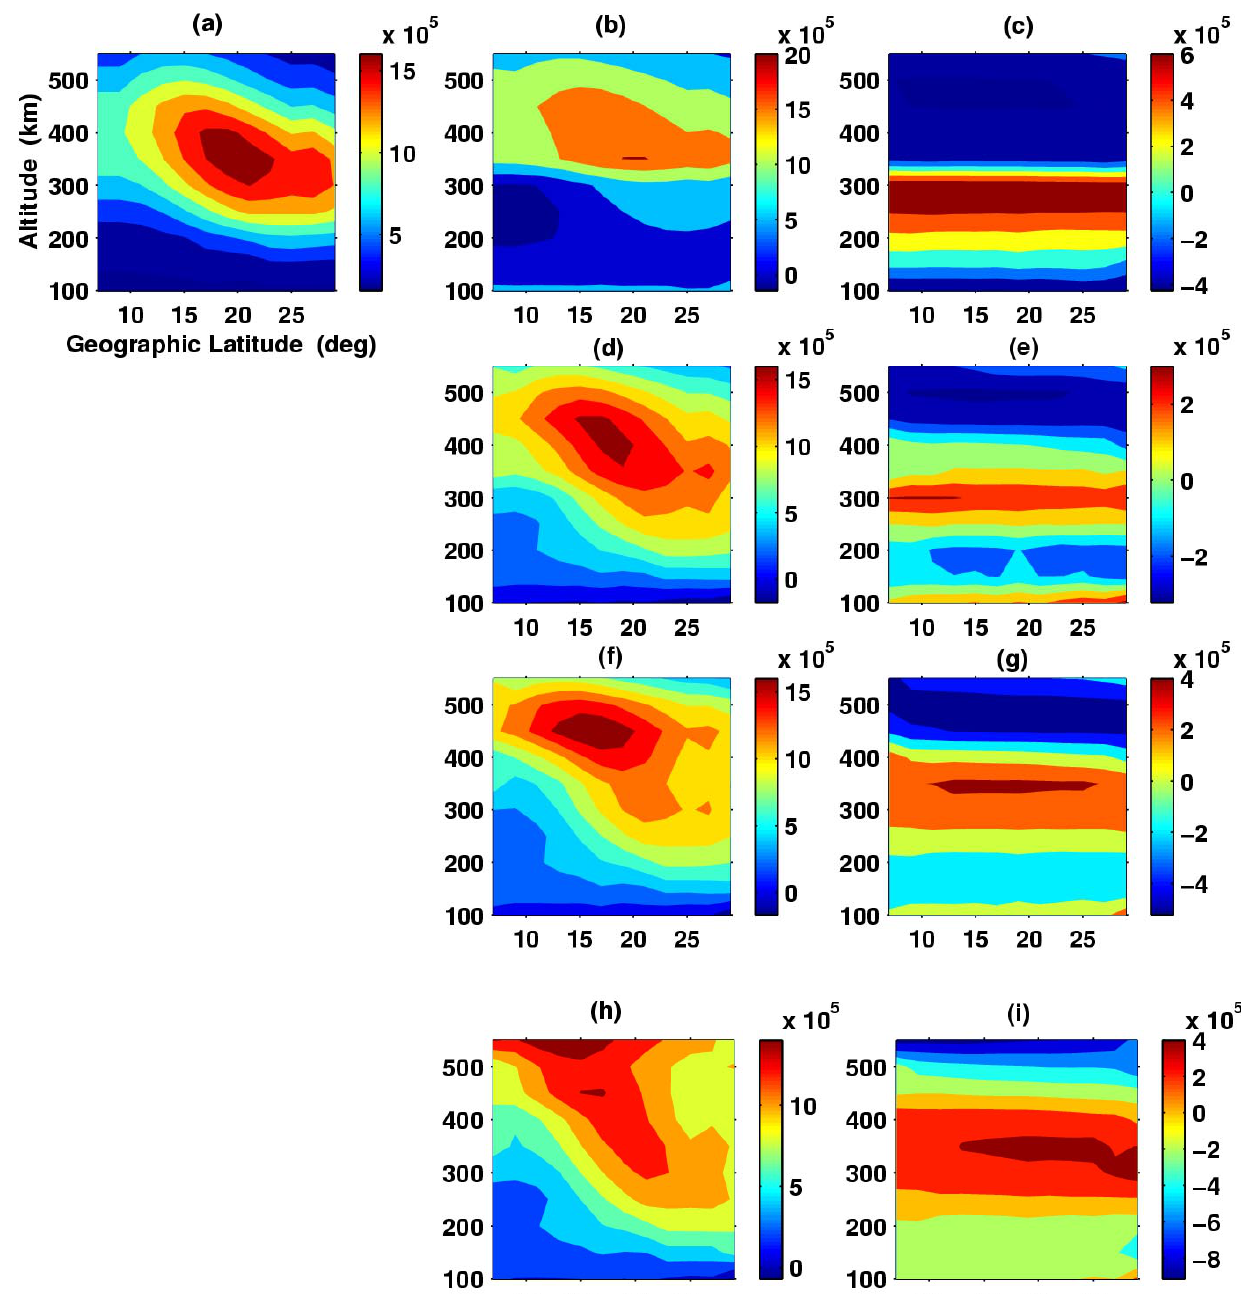
Fig. 9. ( a ) Same as Fig. 8a. ( b ) Reconstruction with a bias error of 5% of the minimum TEC when the 3 smallest singular values are truncated. ( d ) Reconstruction with a bias error of 5% of the minimum TEC when the 4 smallest singular values are truncated. ( f ) Reconstruction with a bias error of 5% of the minimum TEC when the 5 smallest singular values are truncated. ( h ) Reconstruction with a bias error of 5% of the minimum TEC when the 8 smallest singular values are truncated. ( c , e , g , i ) The corresponding differences from the model in Fig. 9a.